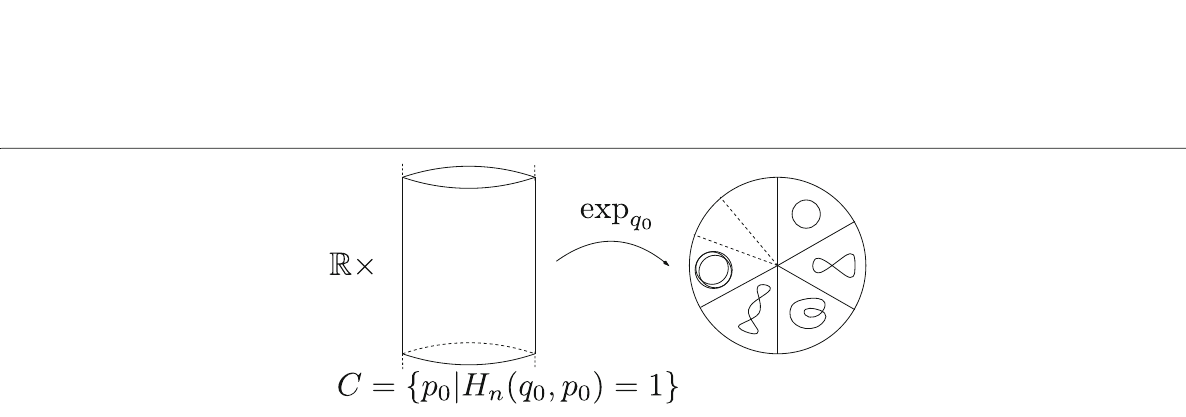
Fig. 9 Schematic representation of the exponential mapping and micro-sectors for periodic